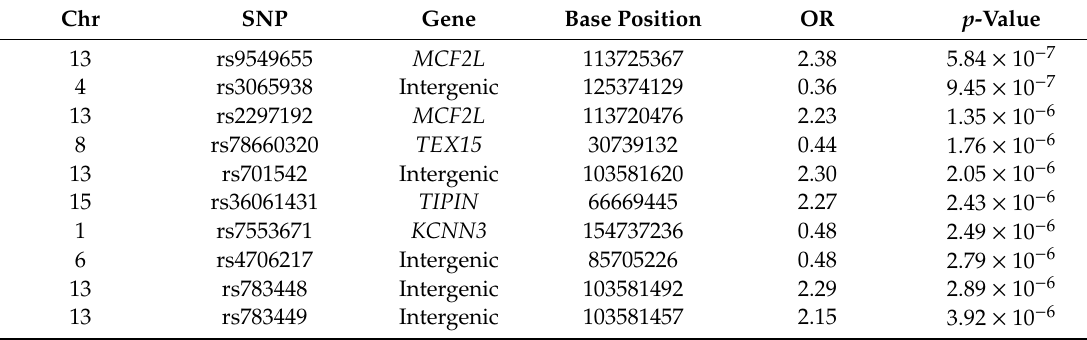
Table 1. Top single-nucleotide polymorphisms (SNPs) following individual variant analysis of the imputed West Nile virus (WNV) dataset. The table shows the top 10 results by chromosome (Chr), single-nucleotide polymorphism (SNP), corresponding gene, base position, odds ratio (OR), and p -value. None of the interactions passed the Bonferroni-corrected p -value of 5 × 10 − 8 . Gene acronyms: MCF.2 Cell Line Derived Transforming Sequence Like ( MCF2L ), Testis Expressed 15, Meiosis and Synapsis Associated ( TEX15 ), TIMELESS Interacting Protein ( TIPIN ), Potassium Calcium-Activated Channel Subfamily N Member 3 ( KCNN3